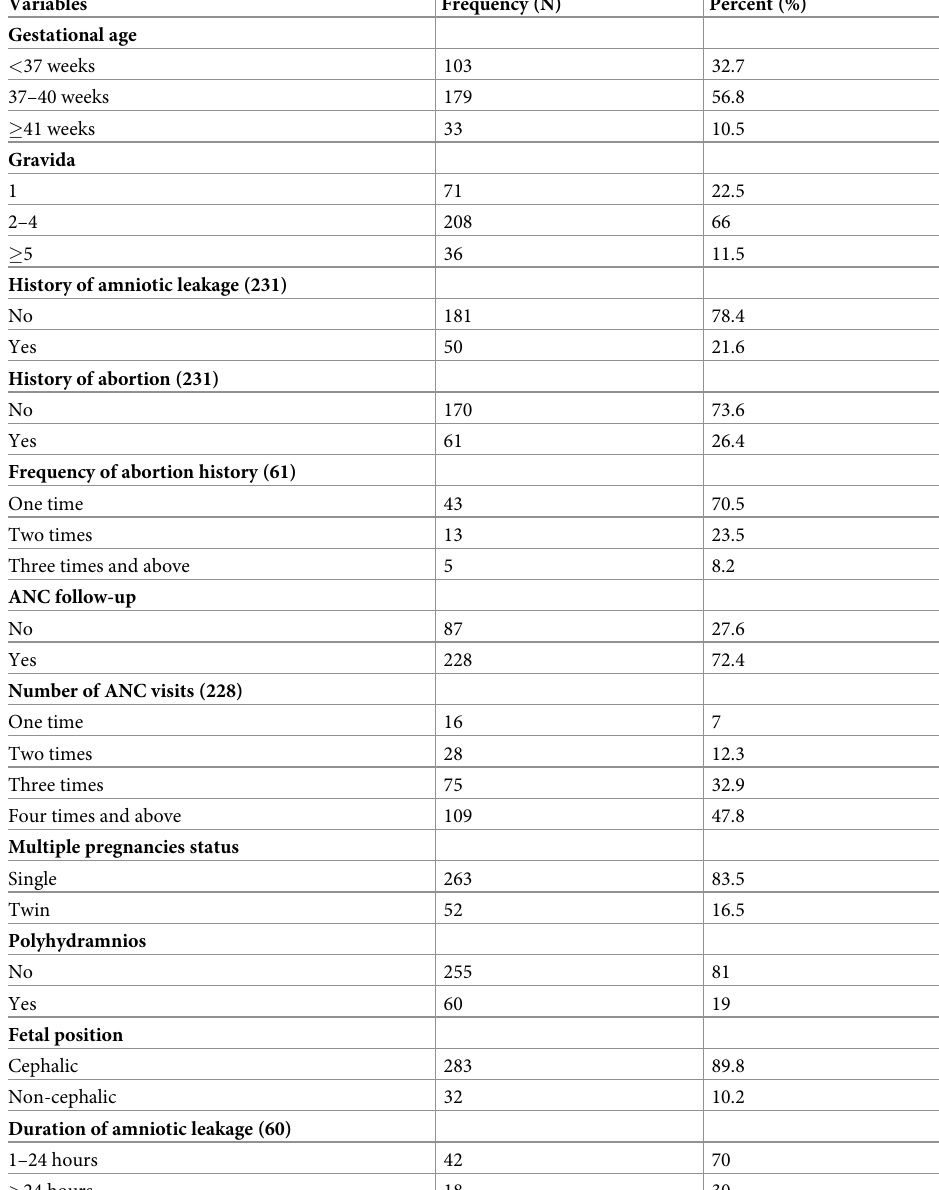
Table 2. Obstetrics and gynecologic-related characteristics of PROM among pregnant women admitted to the maternity ward at Debre Markos Referral Hospital, 2019. Variables Frequency